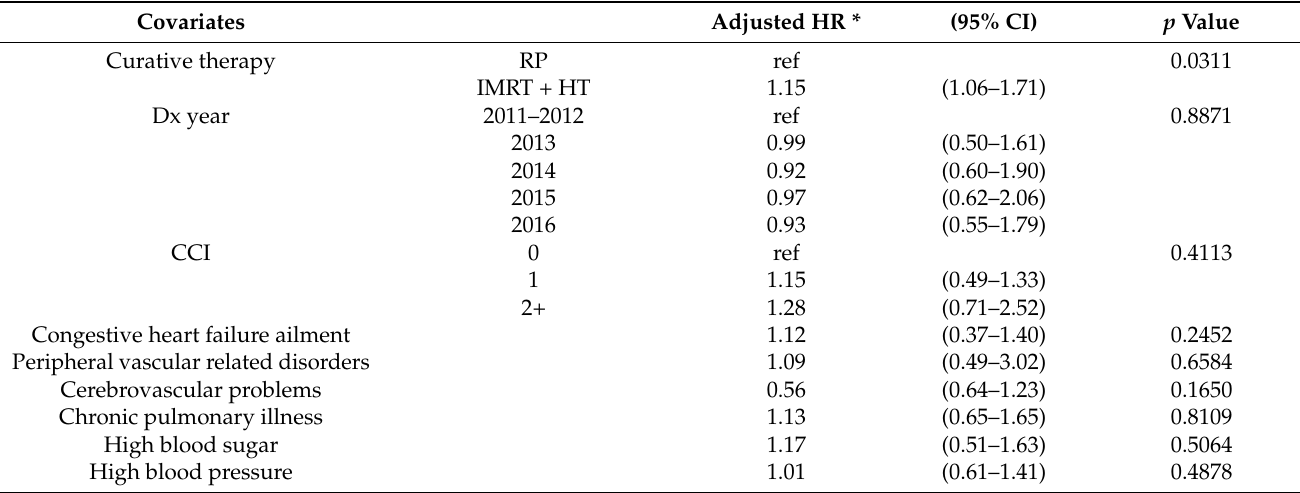
Table 4. The AV-LPC statistics on distant metastasis: Multivariate Cox regression